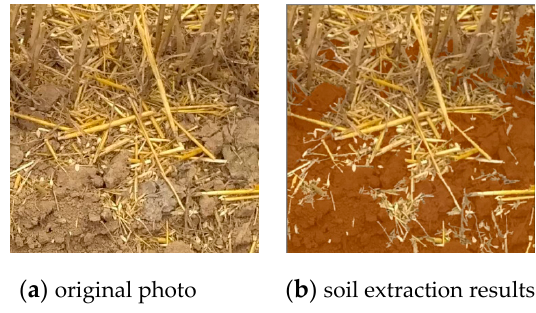
Figure 3. Original photo and the processing result s.